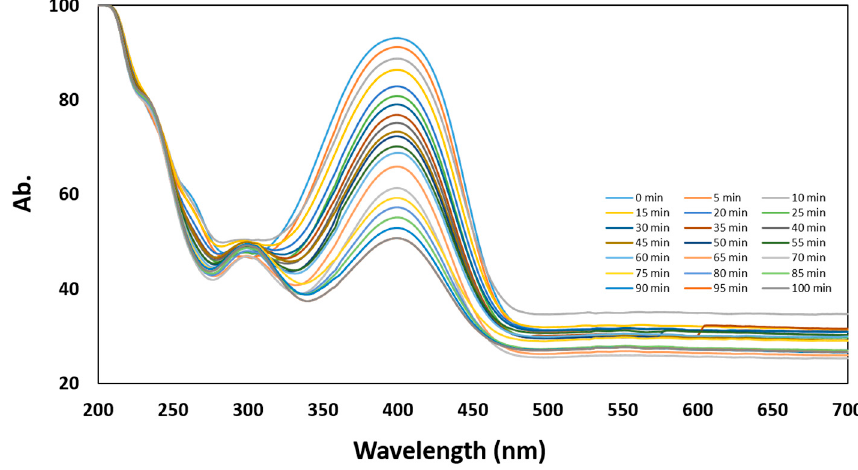
Figure 8. UV-vis spectra of reduction of 4-Nitrophenol using as-synthesized Au NPs.